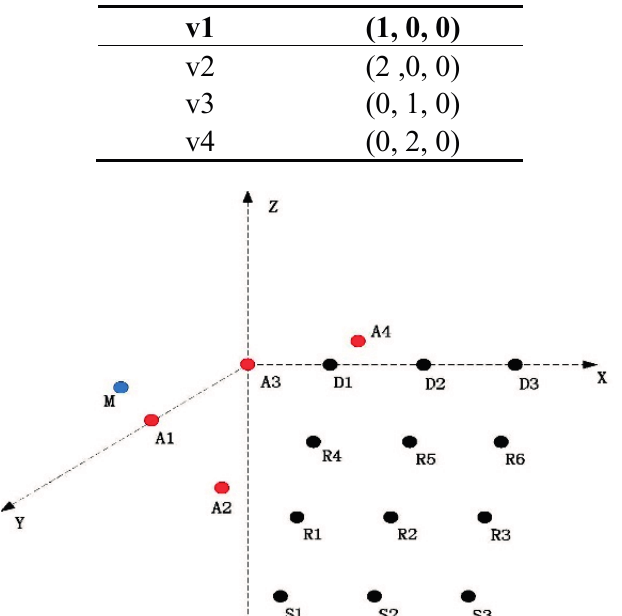
Table 5. Velocity setting.